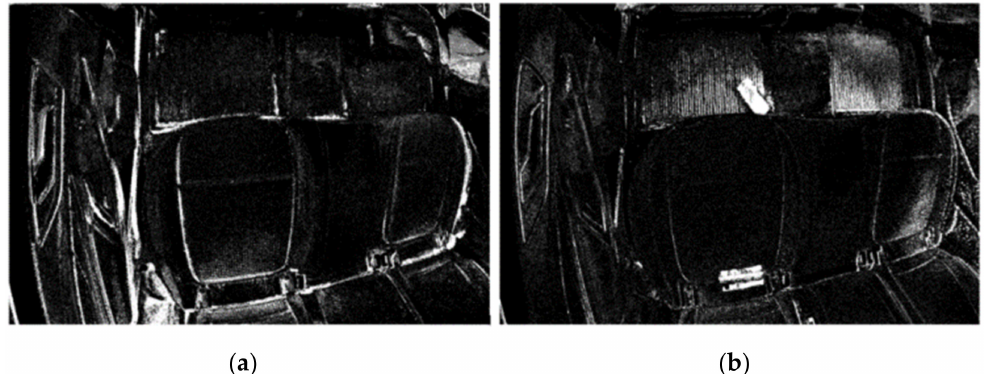
Figure 10. Outcome of imposing background subtraction for an ( a ) empty seating area and ( b ) seating area consisting of